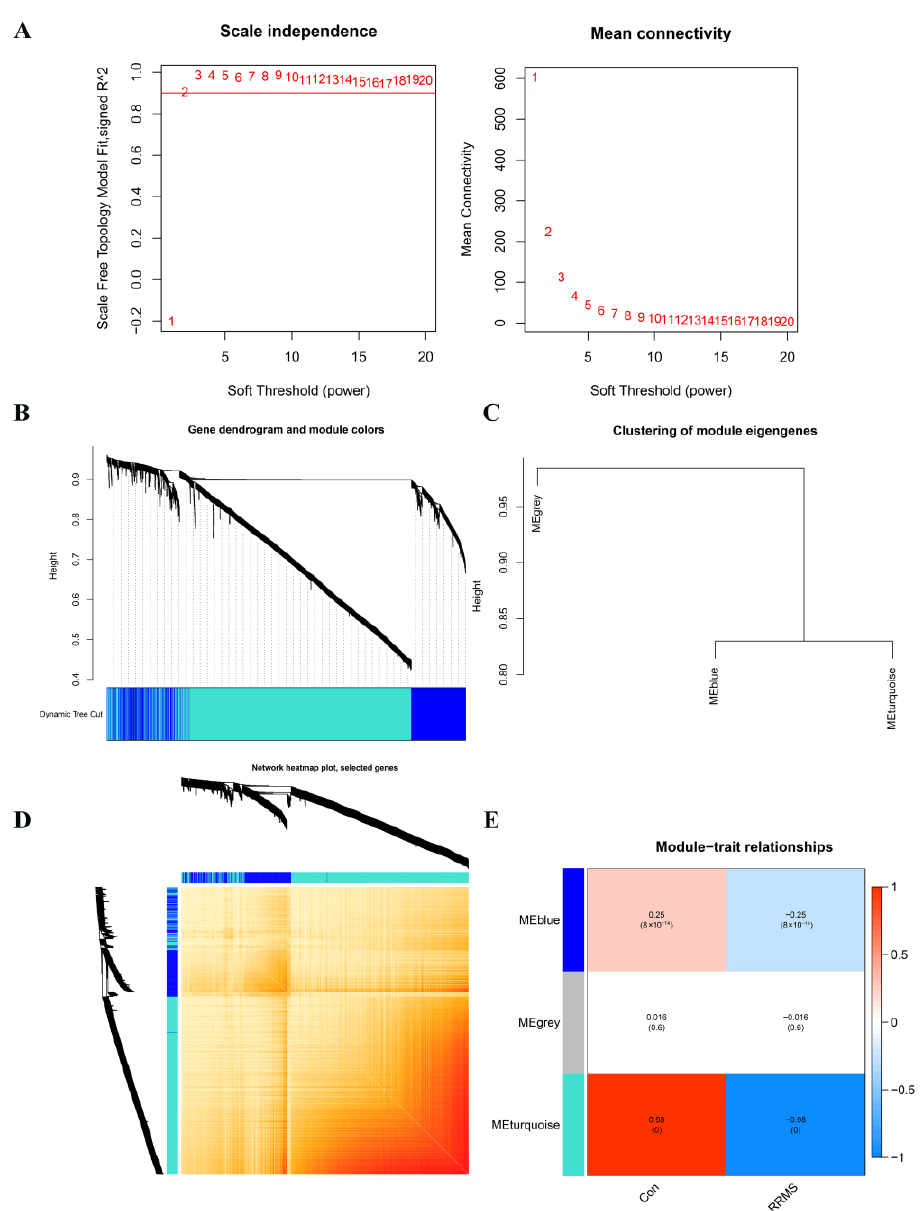
Figure 3. Identification of module genes by WGCNA analysis between RRMS and healthy control groups. ( A ) Network topology analysis for various soft threshold powers. The left figure exhibits the optimal soft threshold selected by the scale-free index analysis. The right figure shows the mean connectivity analysis for various soft threshold powers. ( B ) Clustering tree diagram of co-expression modules based on topological overlap, with different colors representing different co-expression modules determined by the dynamic tree cut. The modules represent highly interrelated gene